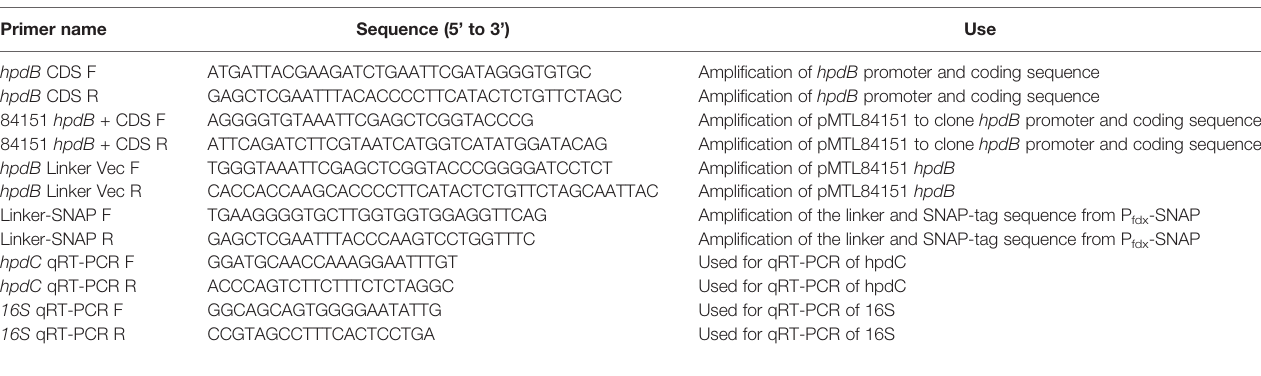
TABLE 2 | Oligos used in this